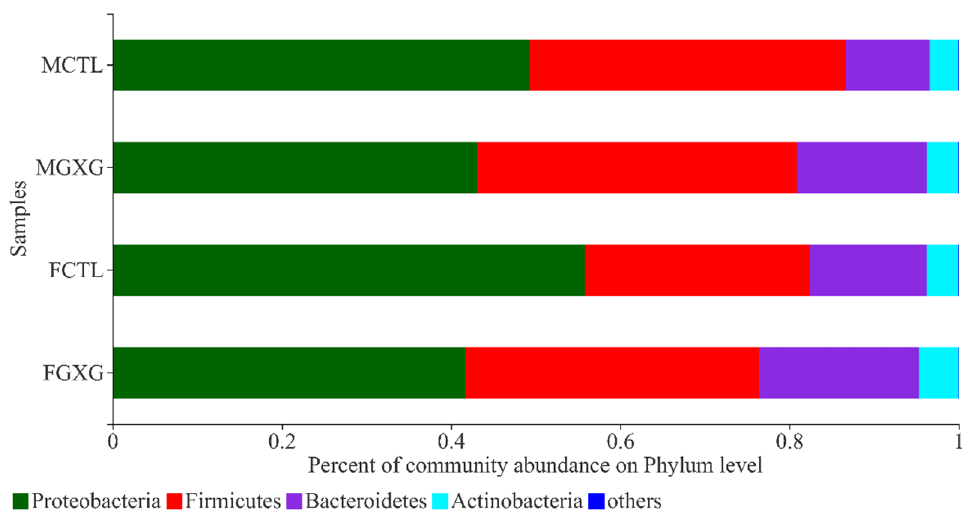
Figure 2. PCA analysis of the effect of Dendrobium officinale polysaccharides on microbiota compo- sition. ( A ): men’s phylum level; ( B ): women’s phylum level; ( C ): men’s genus level ( D ): women’s genus level.